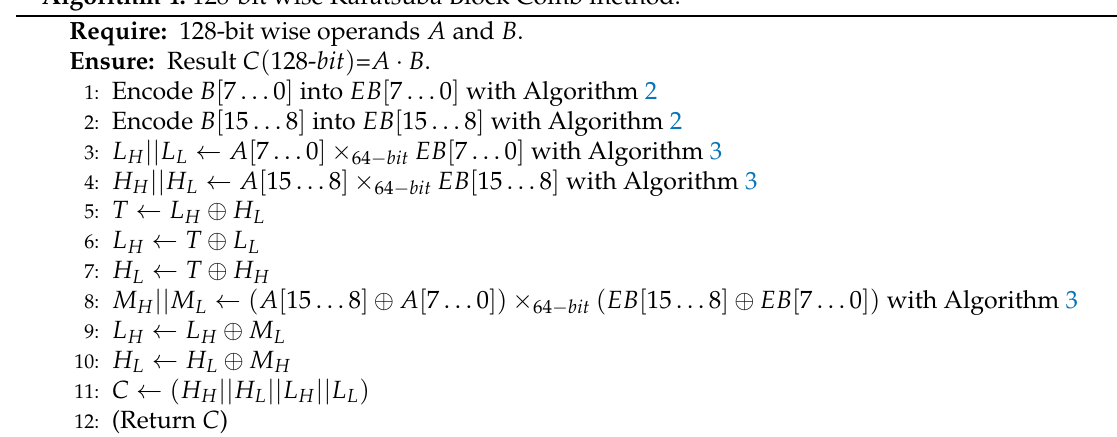
Algorithm 4: 128-bit wise Karatsuba Block Comb